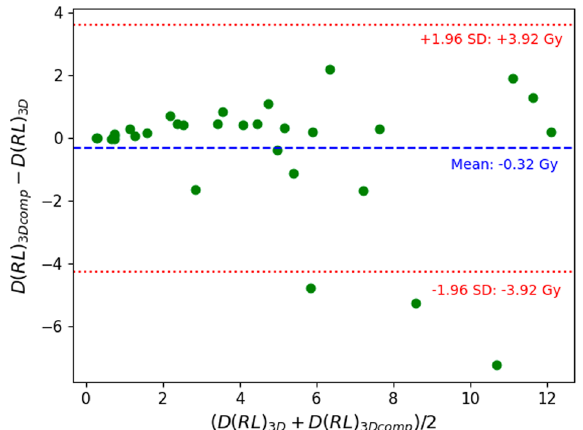
Fig. 9 Bland–Altman plot of the right lung dose (Gy) between 3D and 3Dcomp reconstructions for each patient. D(RL)